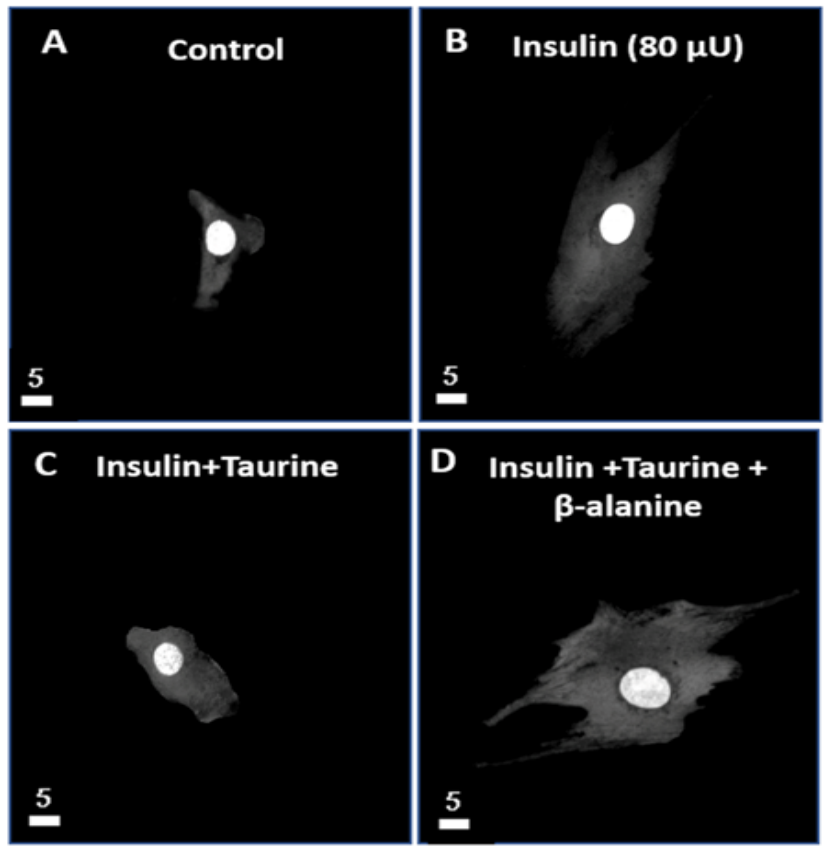
Figure 1. Effect of a 48-h treatment with insulin (80 μ U/mL), insulin (80 μ U/mL) with taurine (20 mM), and insulin (80 μ U/mL) with taurine (20 mM) and β -alanine (500 μ M) on the volume of adult rat ventricular cardiomyocytes. Examples of quantitative 3-D images (top view) of isolated ventricular cardiomyocytes in absence of treatment ( A ), in presence of insulin (80 μ U/mL) ( B ), in presence of insulin (80 μ U/mL) + taurine (20 mM) ( C ), and in presence of insulin (80 μ U/mL) + taurine (20 mM) + β -alanine (500 μ M) ( D ). The white bar scale is in μ m. ( A – D ) are different cells.